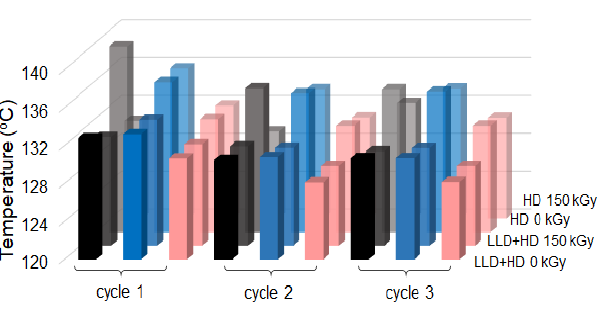
Figure 14. Correlation of T max ( (cid:4) ) from heating ρ -T curves with T offset ( (cid:4) ) and T max ( (cid:4) ) from heating DSC curves. The color intensities decrease, from front to back, in order to facilitate the comparison of the parameters.